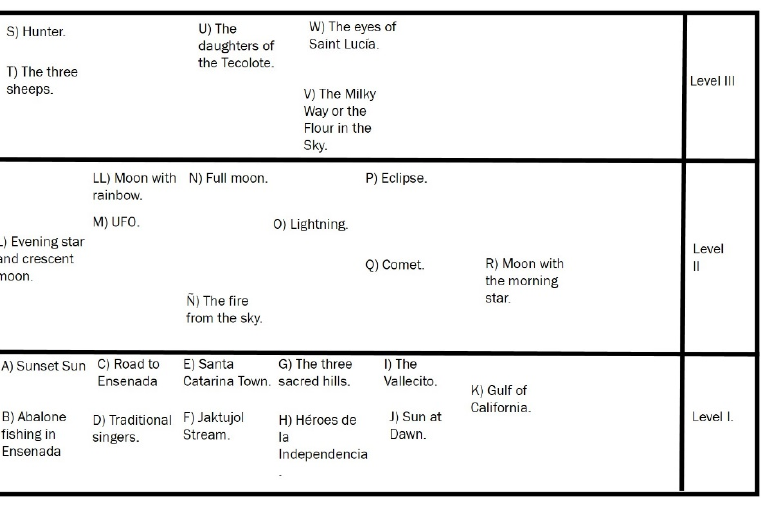
Figure 1. Pa Ipai sky cybercartographic atlas.